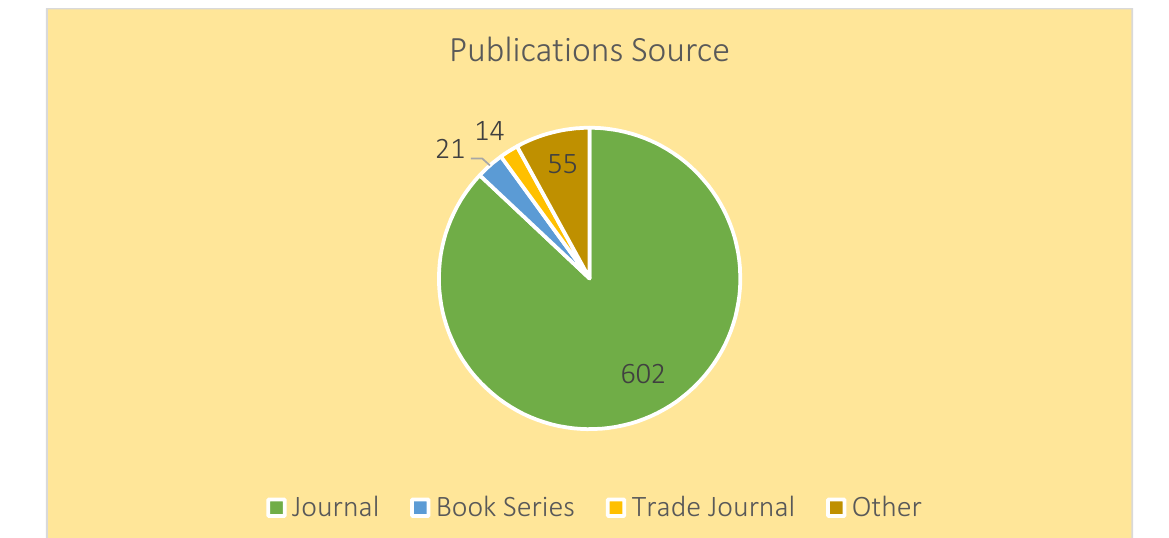
Figure 4. Publication sources of the matching 692 publications from database searches.